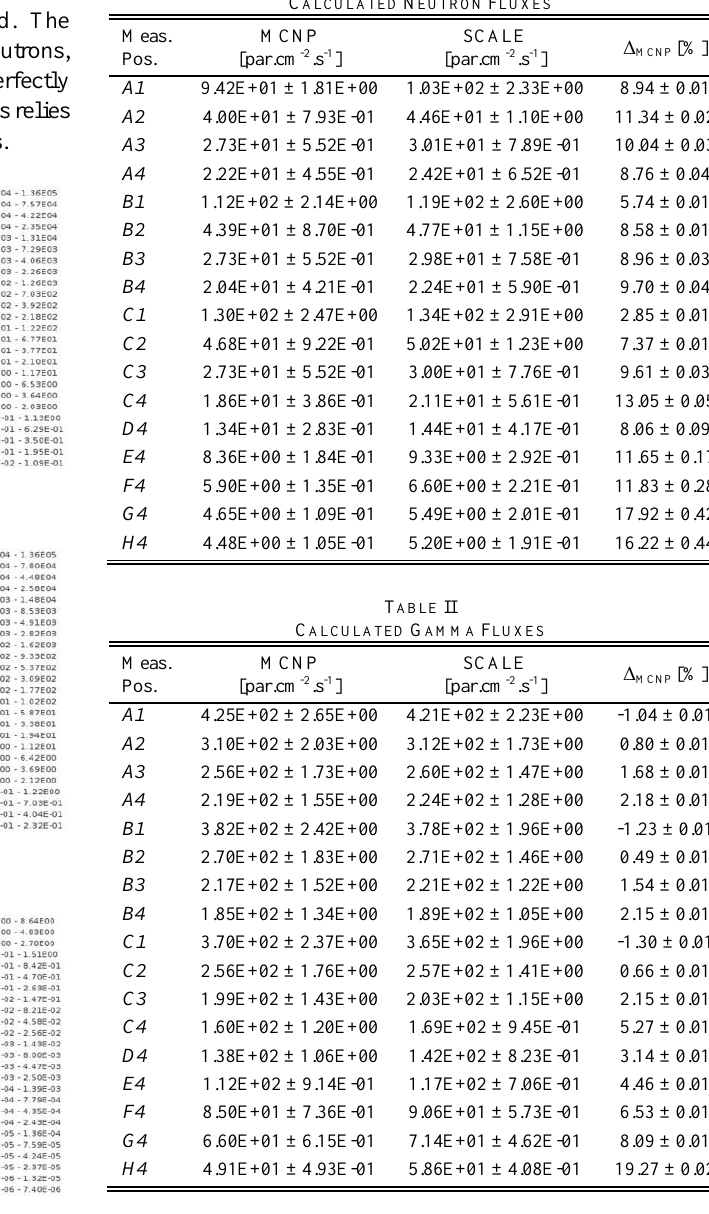
Fig. 9. Relative change of total photon flux (MCNP as